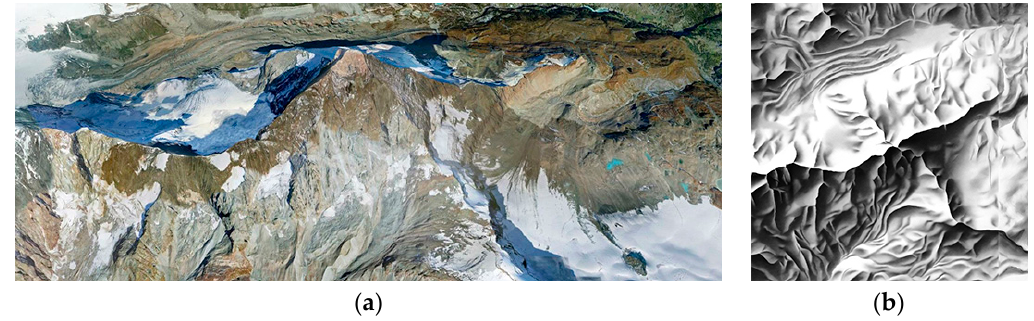
Figure 1. Block mountain sample area: ( a ) oblique aerial view; ( b ) manual relief shading.